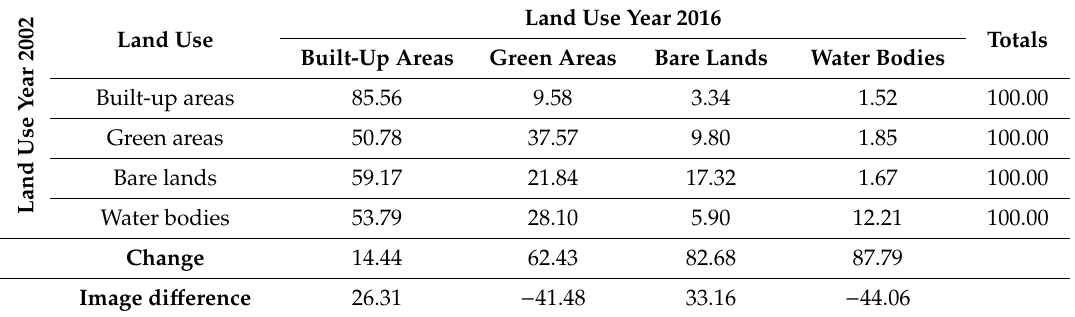
Table 5. Spatial land-use change between